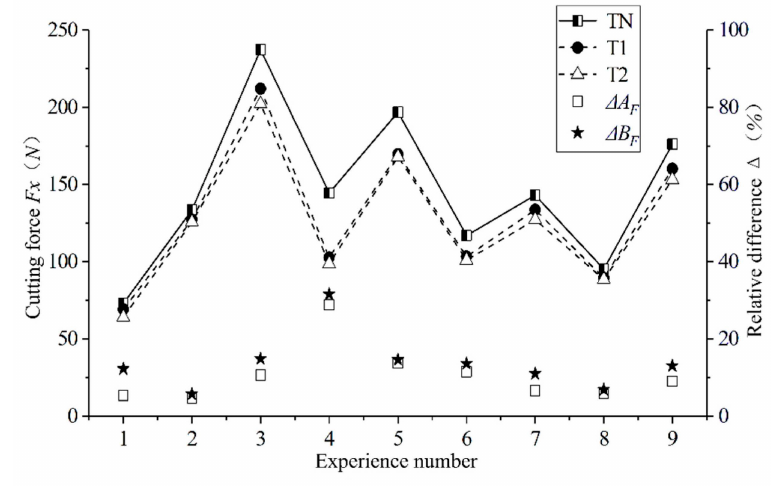
Figure 10. Cutting force comparison of different cutting parameters with different cutting tools.